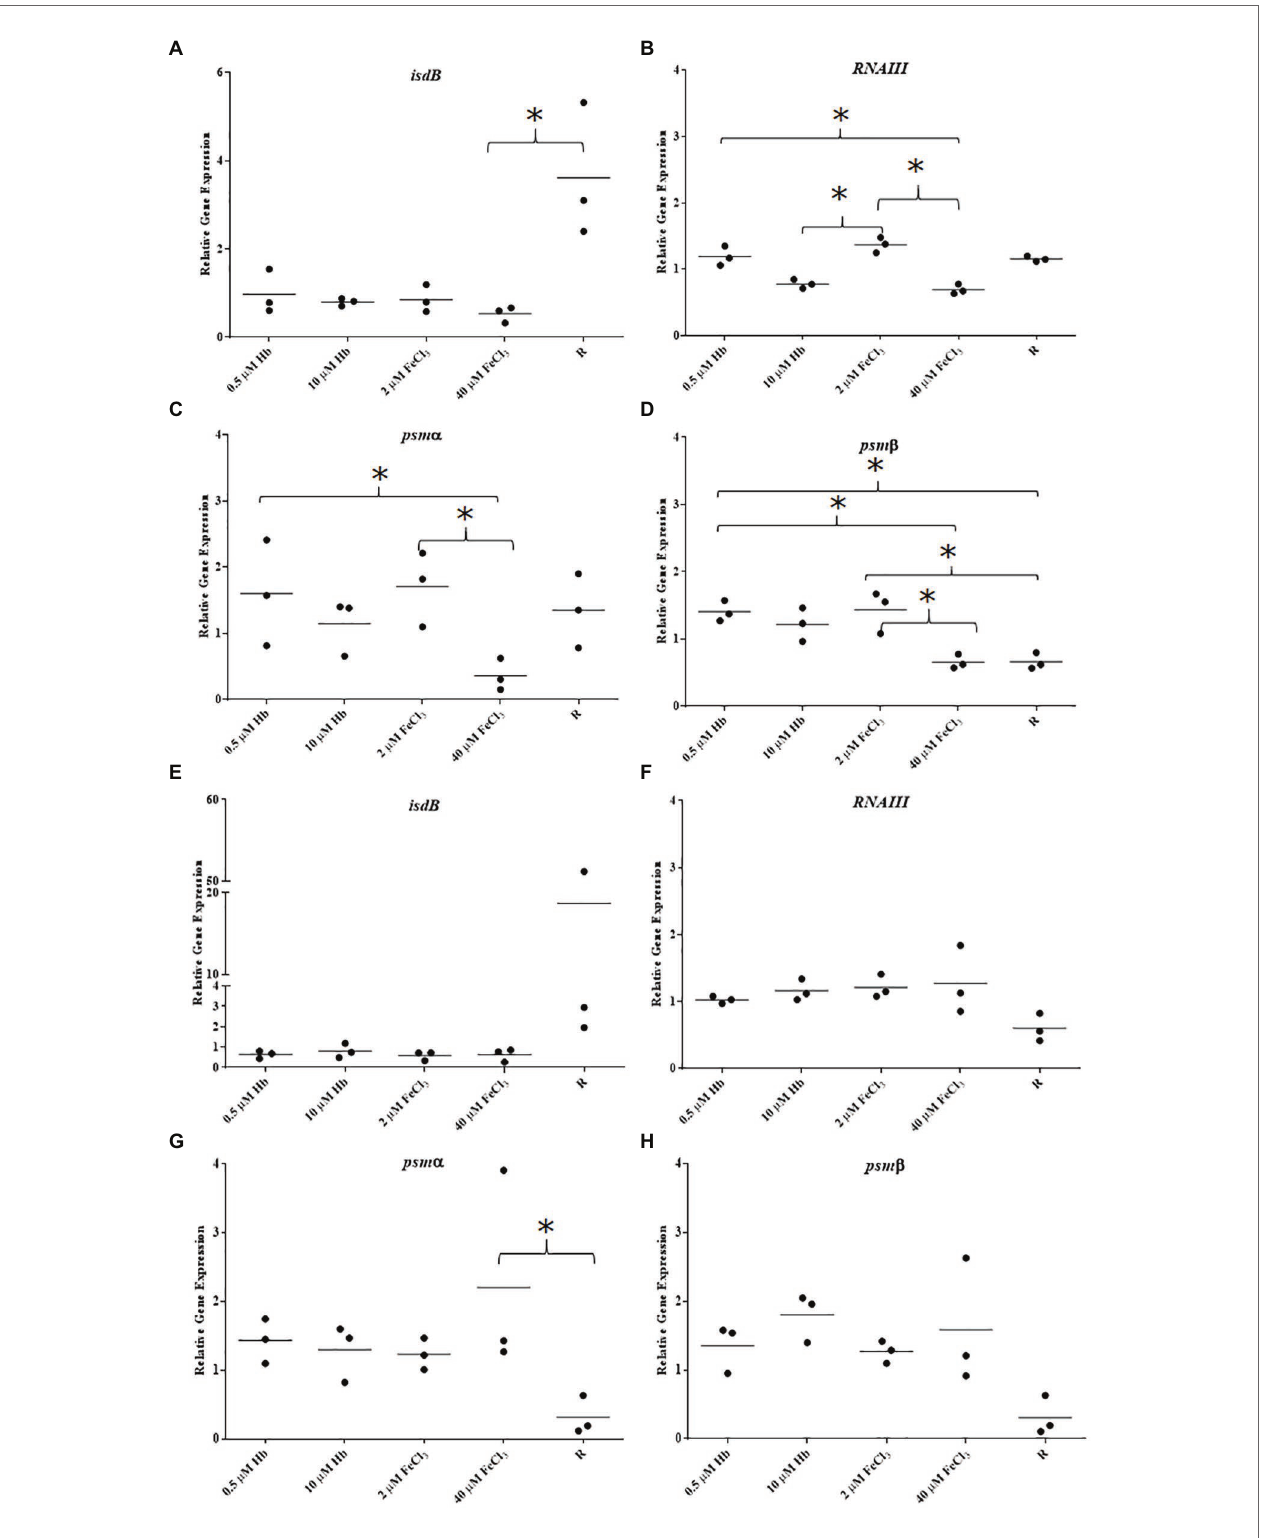
FIGURE 6 | Gene expression in biofilms of clinical isolates BC03 and EC12. (A) , BC03 isdB ; (B) , BC03 RNAIII ; (C) , BC03 psm α ; (D) , BC03 psm β ; (E) , EC12 isdB ; (F) , EC12 RNAIII ; (G) , EC12 psm α ; and (H) , EC12 psm β . Data is plotted as mean of three biological replicates each including technical triplicates. Stars denote significant differences ( p < 0.05) analyzed by one-way ANOVA, Kruskall-Wallis